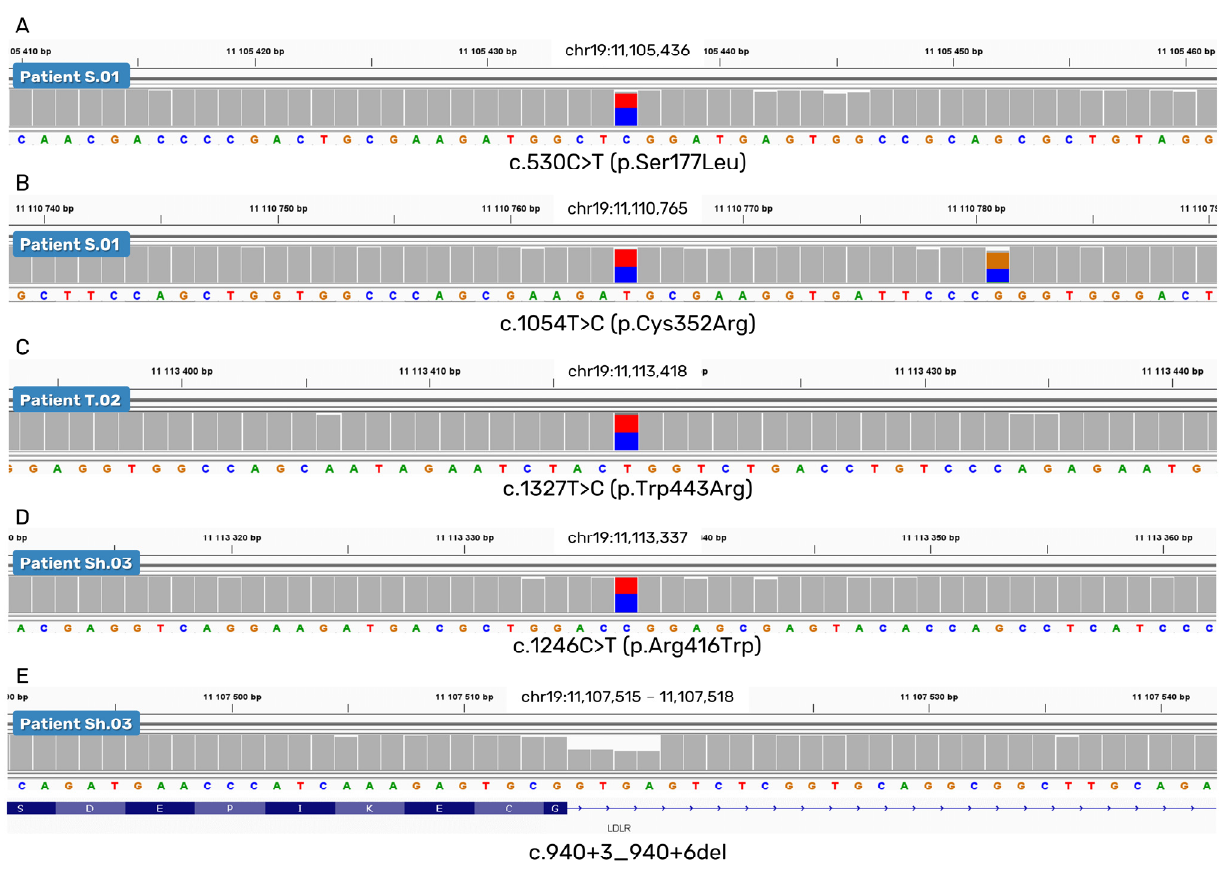
Figure 2. Missense and short deletion variants of the LDLR gene were detected by nanopore sequenc- ing. A trace from the IGV software is shown for each sample carrying a mutation. ( A , B ) c.530C>T and c.1054T>C of patient S.01; ( C ) c.1327T>C of patient T.02; ( D , E ) c.1246C>T and c.940+3_940+6del of patient Sh.03.